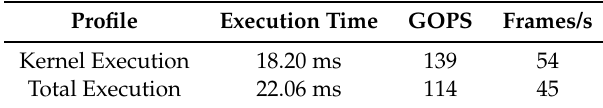
Table 4. Execution times when executing the sliding window implementation of the guided filter on the HARP platform.